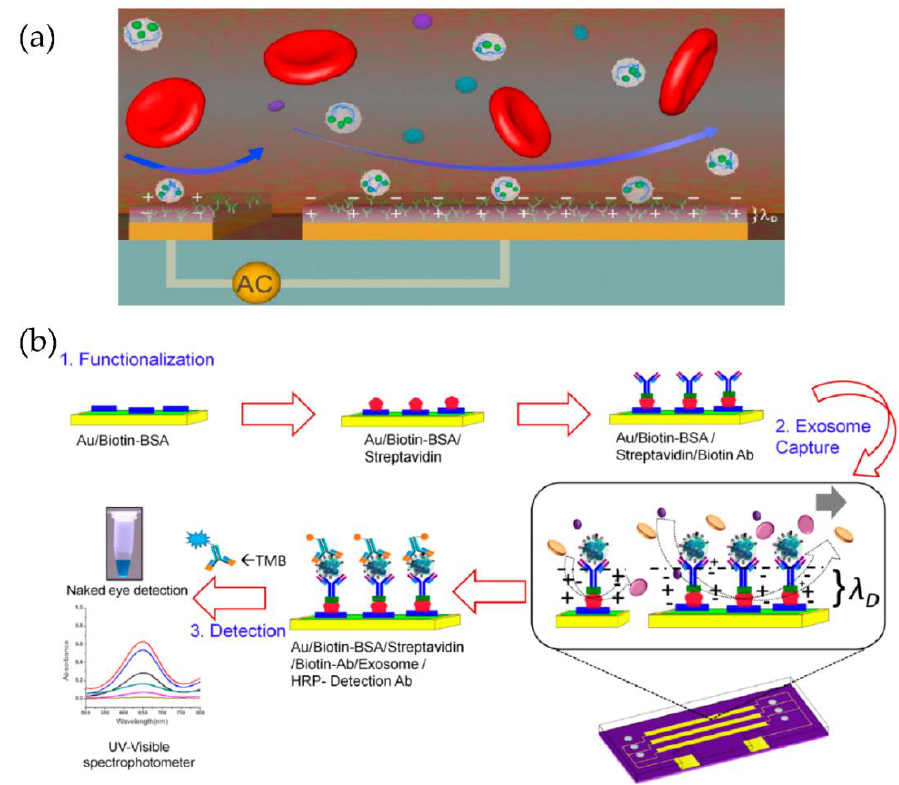
Figure 18. Tuneable alternating current electro hydrodynamic nanoshearing device for the detection of exosomes. ( a ) Schematic representation of ac-EHD induced device (appears as white spherical particles). ( b ) Schematic representation of the functionalization protocol. (Reproduced with permission from Vaidyanathan R. et al. [83]. Copyright 2014, American Chemical Society).